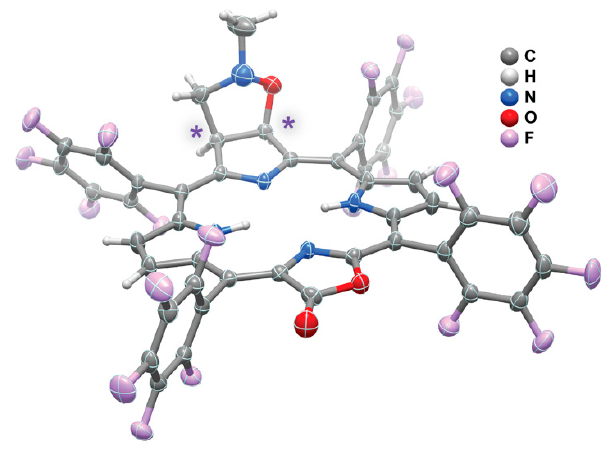
Figure 4. Oak Ridge Thermal Ellipsoid Plot (ORTEP) representation of the nitrone cycloadduct 6a derivative. Non-hydrogen atoms are represented as thermal ellipsoids drawn at the 50% probability level, and hydrogen atoms as small spheres with arbitrary radii. The chiral centers are indicated by an asterisk.